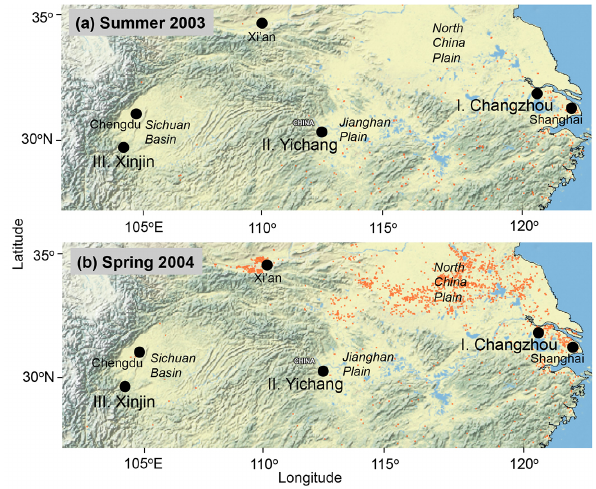
Fig. 4. Spatial distribution of fire spots during (a) late summer (5 August–13 September 2003) and (b) late spring (16 May– 10 June 2004) over central East to West China. The fire data were derived from a Moderate-resolution Imaging Spectroradiome- ter (MODIS) (https://earthdata.nasa.gov/data/near-real-time-data/